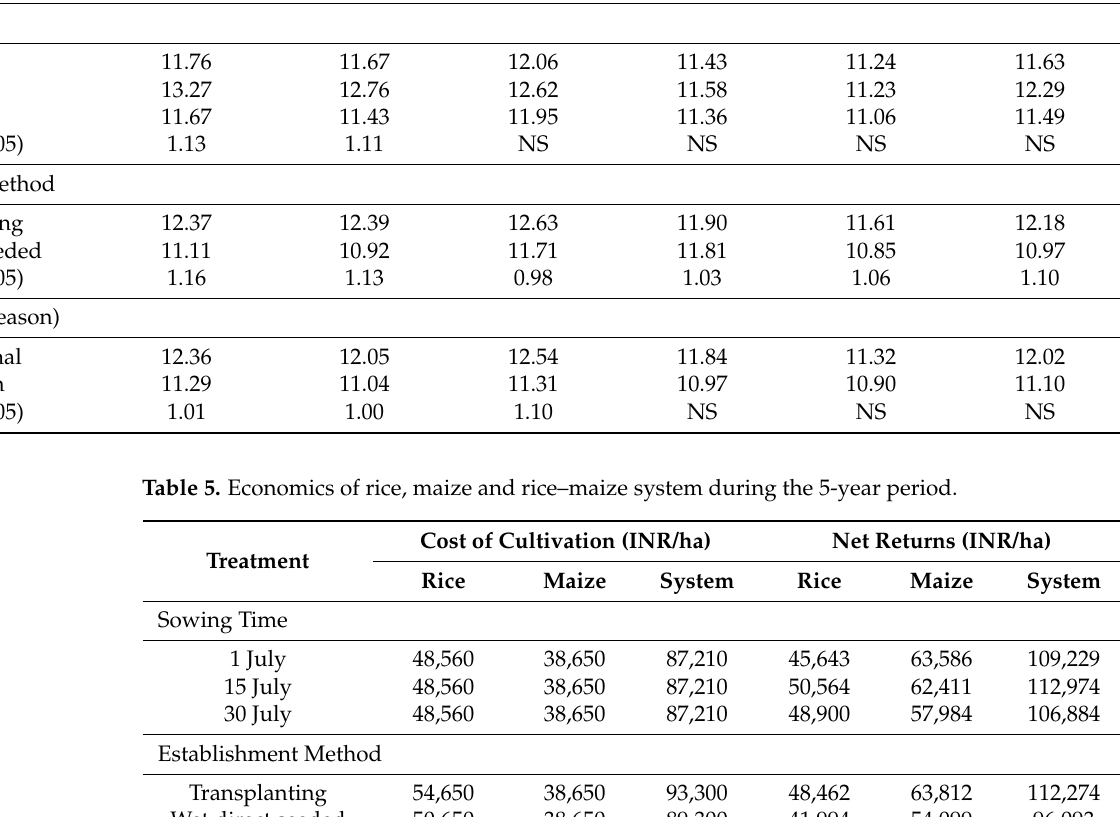
Table 4. Rice–maize productivity (t/ha) obtained under applied treatments during the 5-year period. Treatment